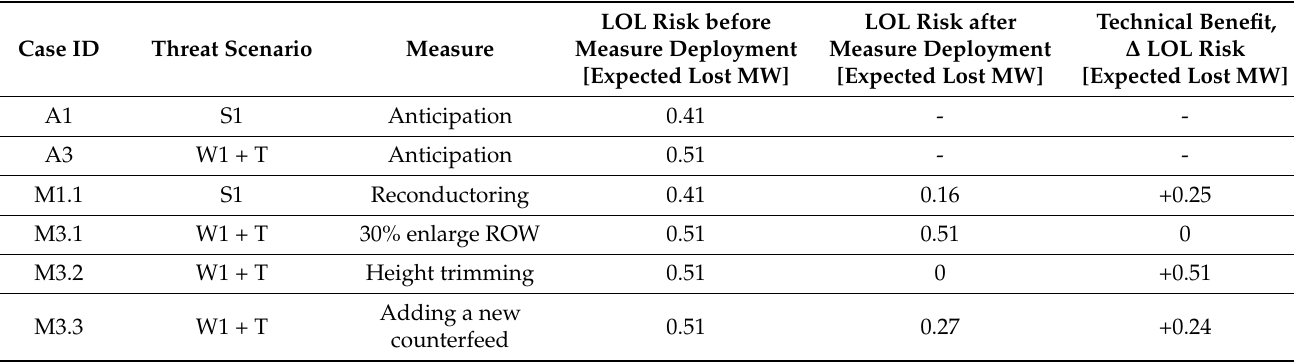
Table 9. Summary of resilience assessment results: LOL risk indicators before and after measure deployment, base cases A1,